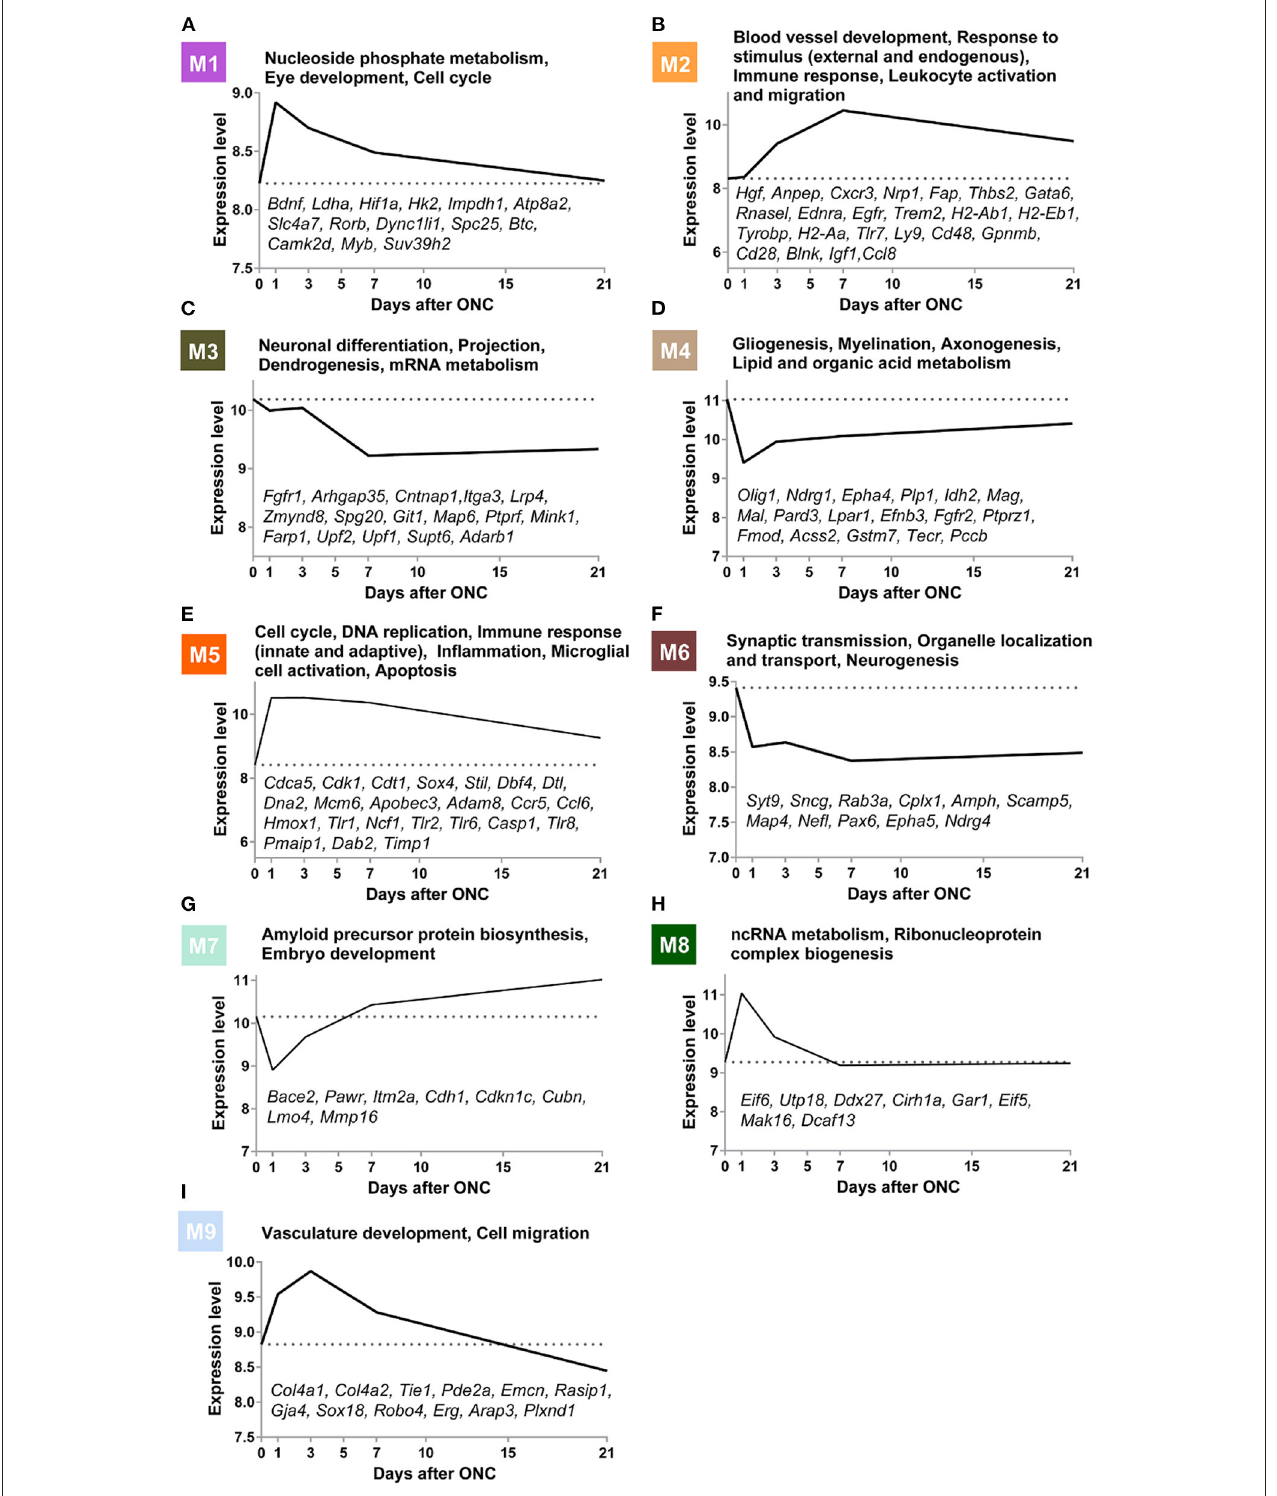
FIGURE 4 | Gene modules underlying biological and pathological events at different time points post-ONC. (A–I) GO terms associated with the M1–M9 modules are shown. The time-course expression curves of the 9 modules based on the average expression levels of the top 30 genes with the highest MM are shown. The gene symbols of crucial genes in each module are shown. GO, Gene Ontology; ONC, optic nerve crush.